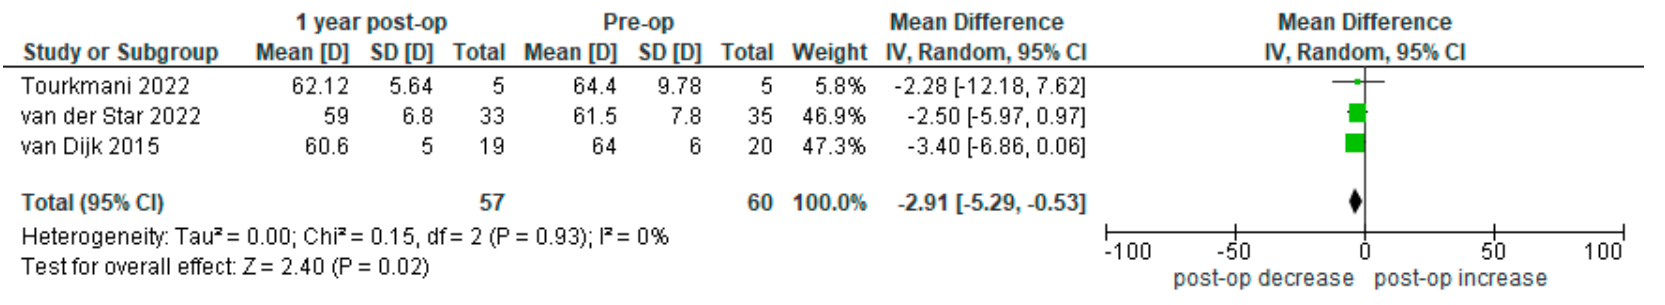
Figure A18. Di ff erence in mean simulated keratometry across 3 studies [31,32,43].